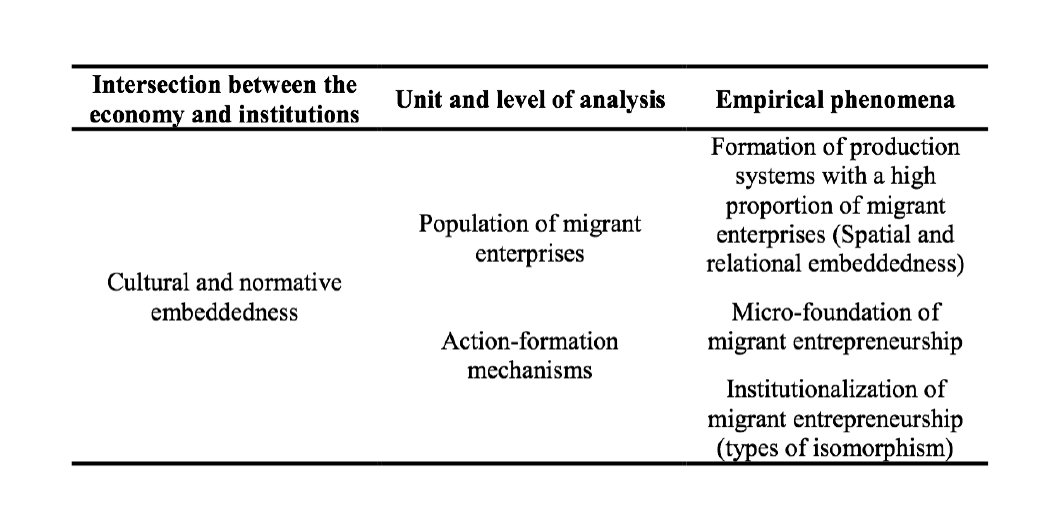
Fig. 2: Additions to the Mixed Embeddedness